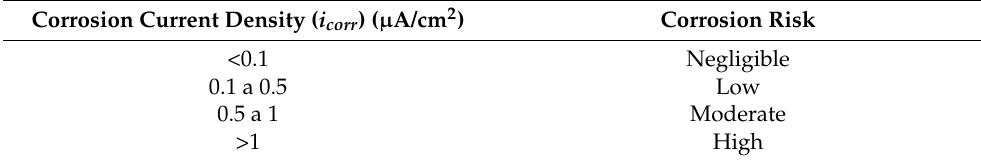
Table 2. Corrosion risk assessed in terms of corrosion current density ( i corr ).